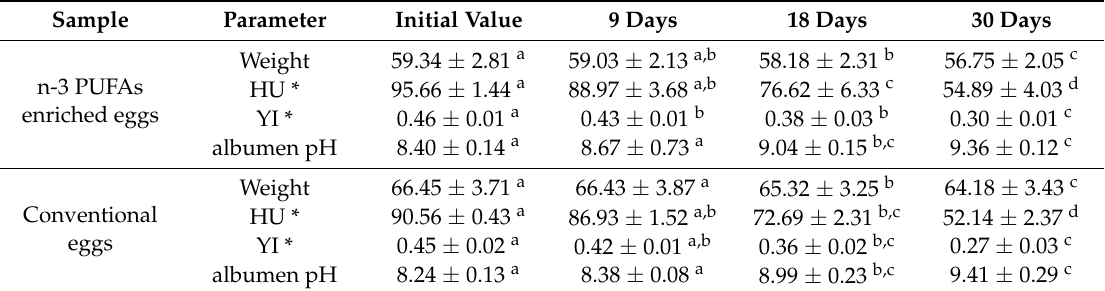
Table 3. The quality * changes of n-3 PUFAs enriched and conventional eggs in refrigeration.